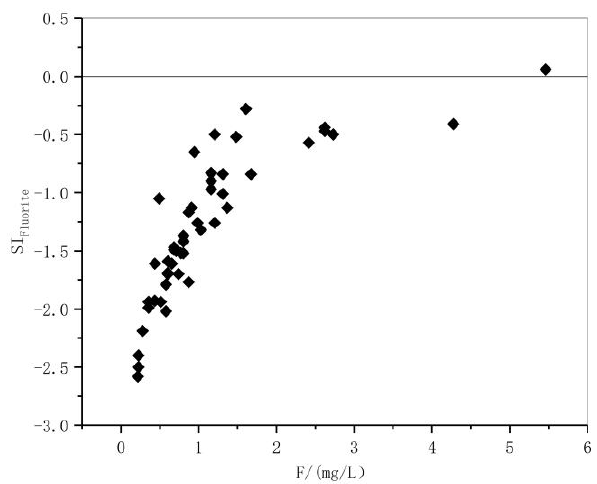
Figure 9. Diagram of the relationship between ρ [F − ] and the fluorite saturation index (fluorite SI). Calcite, dolomite, and fluorite are minerals containing Ca 2+ . Carbonatite sedimentation is one of the Ca 2+ concentration decline mechanisms. According to the results computed via PHREEQC software, both calcite and dolomite in the research area were in the saturation state (Figure 8a,b), and Ca 2+ precipitated in the groundwater as this type of mineral was deposited.